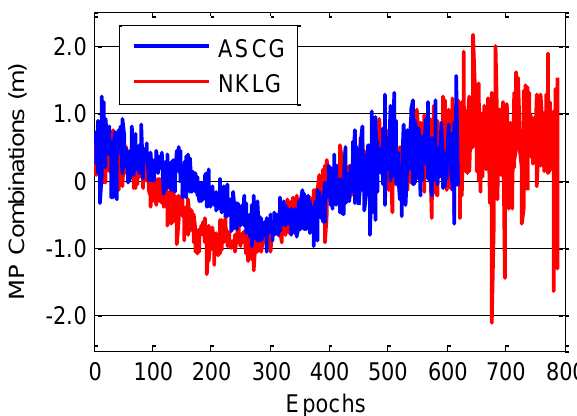
Figure 4. MP combination time series of B1 signal at 800 consecutive epochs for BDS-2 MEO satellite C14 at stations ASCG and NKLG on 19 August 2016.